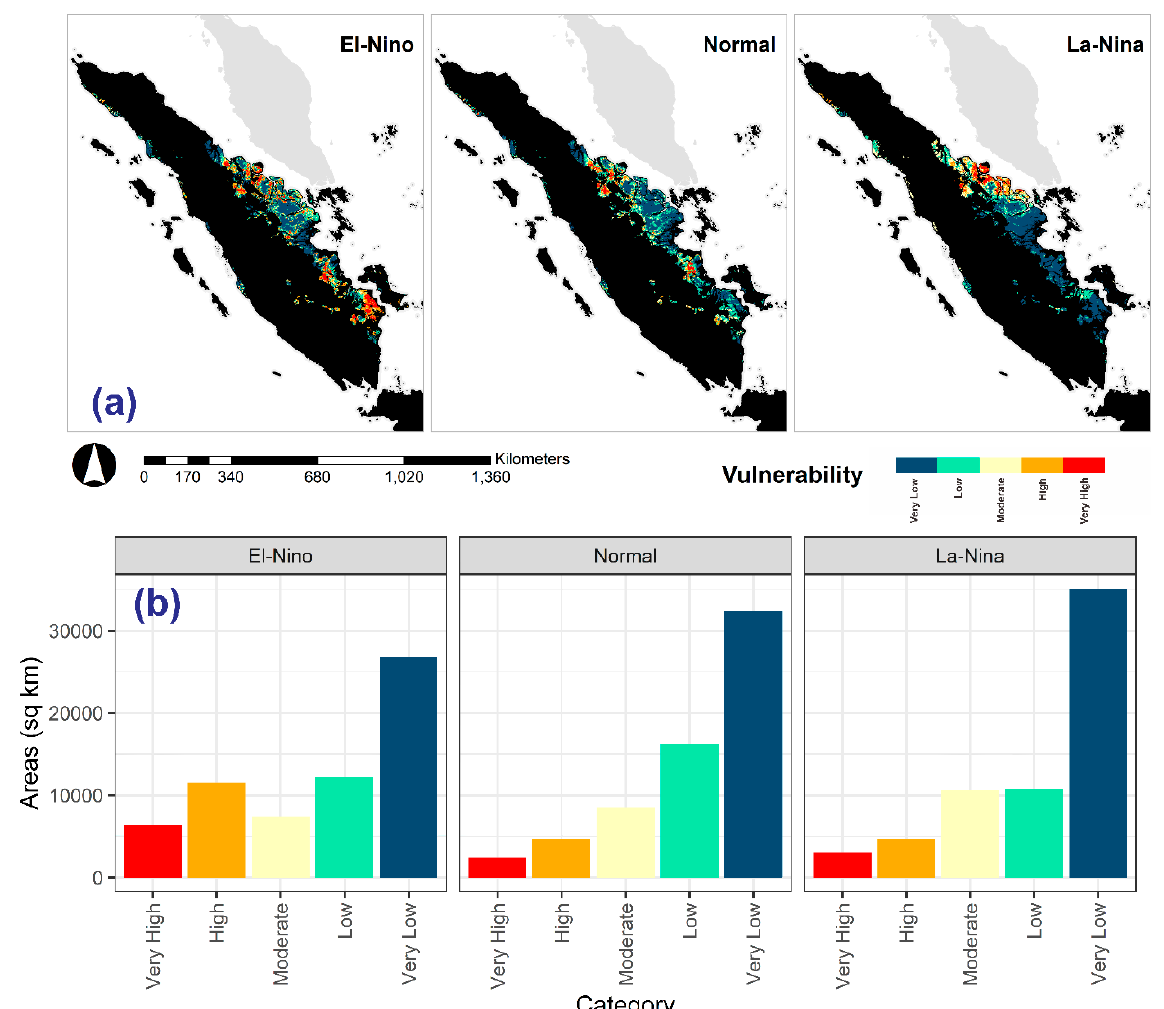
Figure 6. Categorical Sumatran peat vulnerability to fire spatial distribution based on the ensemble model ( a ) and area of each vulnerability class during various ENSO phases ( b ).